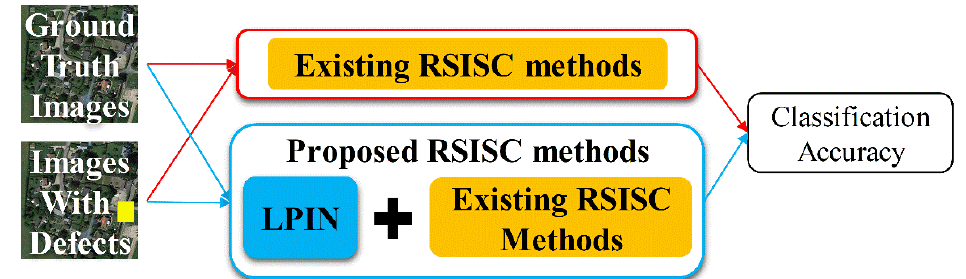
Figure 8. Procedure of the classification accuracy test.